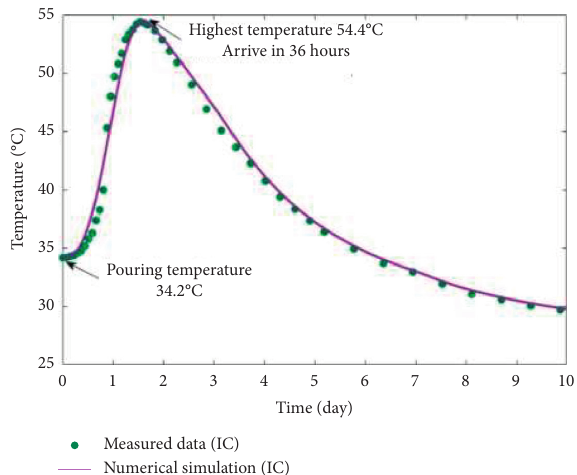
Figure 23: Comparison of measured and simulated temperature duration curves of inspected concrete (IC).